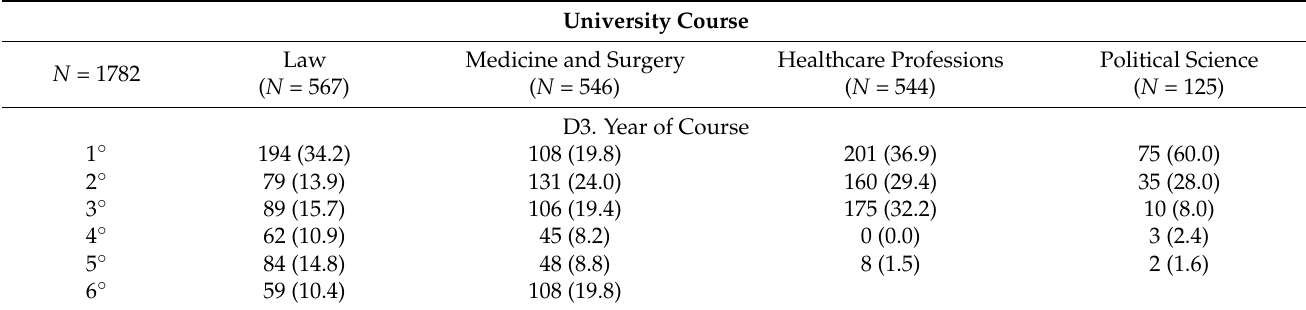
Table 1. Distribution of type and year of degree among the 1782 respondents. The legal number of course years is six years for Medicine and Surgery, five years for Law, three years for Political Science and Healthcare Professions. University Course N =